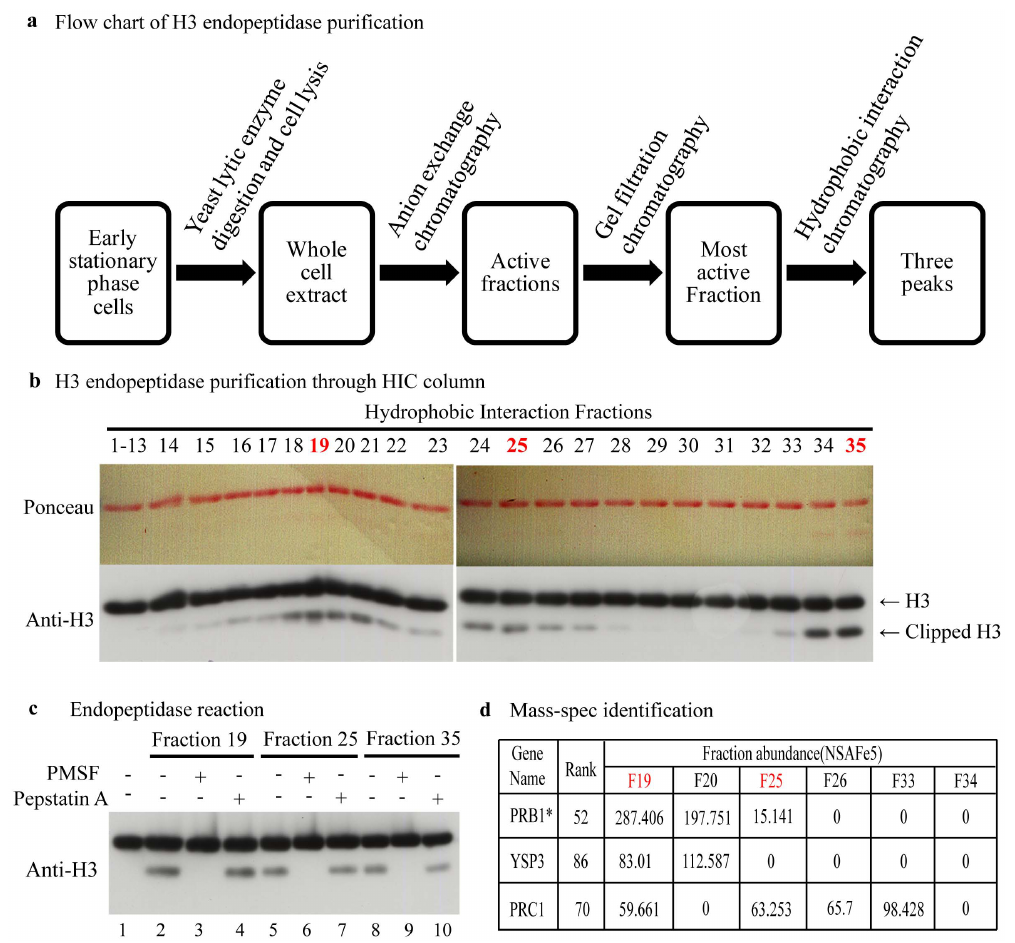
Figure 1. Identifying the histone H3 endopeptidase. (a) Schematic of histone H3 endopeptidase enrichment. Whole cell extract from early stationary phase cells was used to purify the histone H3 endopeptidase. Endopeptidases were purified by chromatography by Anion exchange, Gel filtration and Hydrophobic Interaction. The cleavage activity was measured by western blot with antibody against the H3 C-terminus. (b) H3 endopeptidase assay of the fractions separated by Hydrophobic Interaction Chromatography. The red numbers represent the peaks of cleavage activity (analyzed by Image J). (c) Yeast histone H3 endopeptidases are serine proteases: The H3 endopeptidase activity of Fractions 19, 25 and 35 was assayed with and without protease inhibitors and clipping was assayed by western blot with antibody against the H3 C-terminus. (d) Mass spectrometry analysis of serine protease candidates (Prb1, Ysp3, Prc1) in fractions that include the peaks of endopeptidase activity.